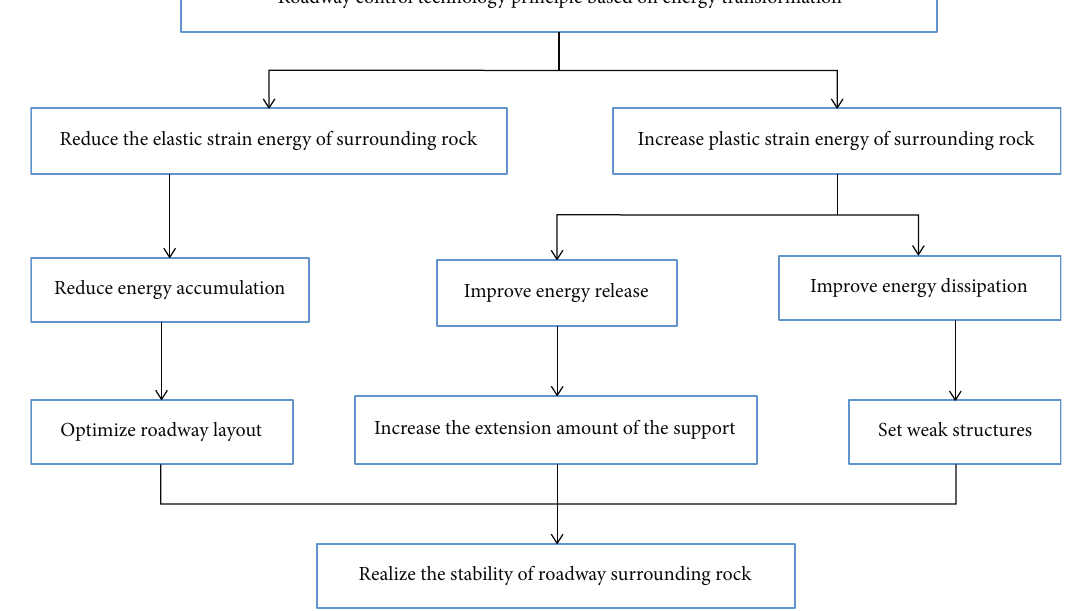
Figure 12: Roadway control technology principle based on the energy transformation.